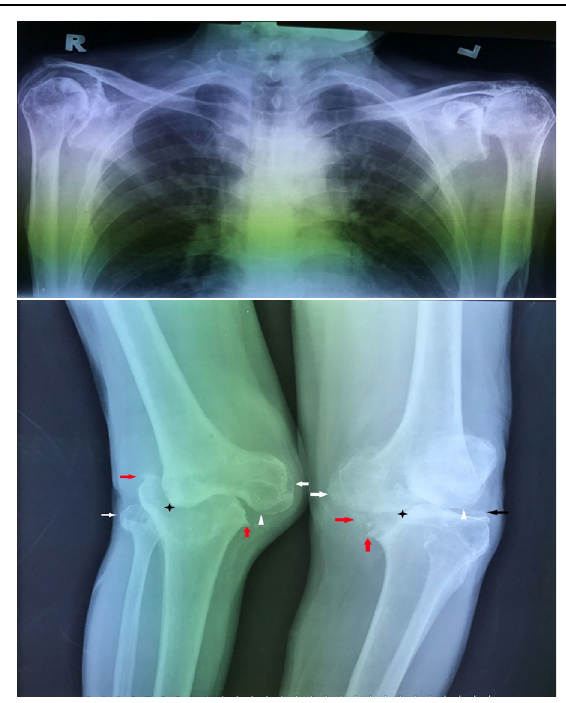
Figure 3 . Bilateral Shoulder Xray and Bilateral Knee Xray (Non-Weight Bearing).